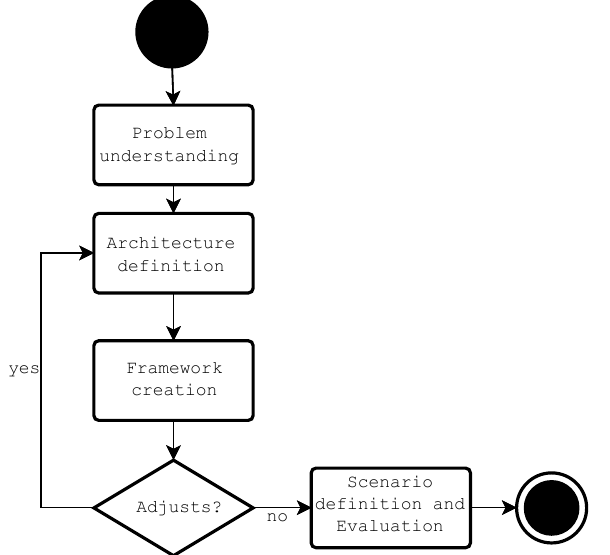
Figure 8. An overview of the research methodology for creating the REFlex